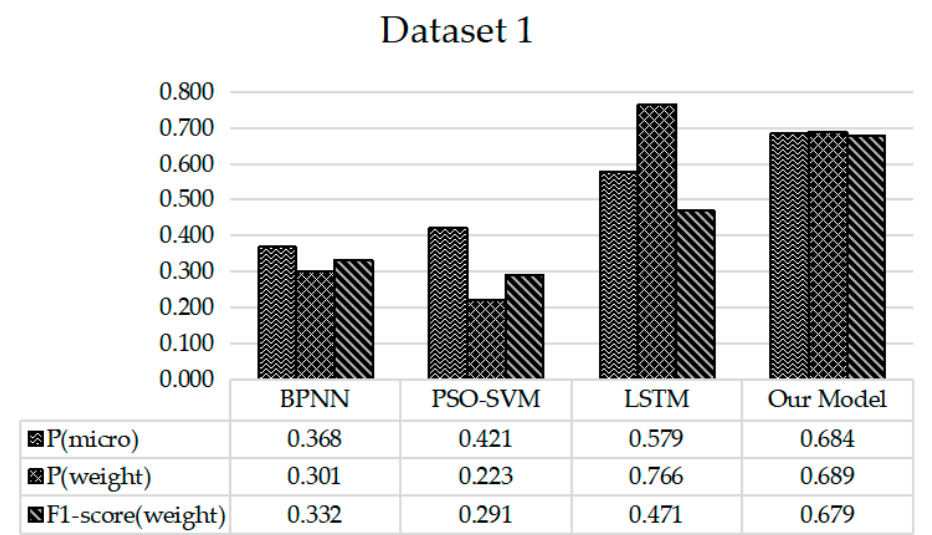
Figure 7. Results of popularity trend prediction on dataset 1.